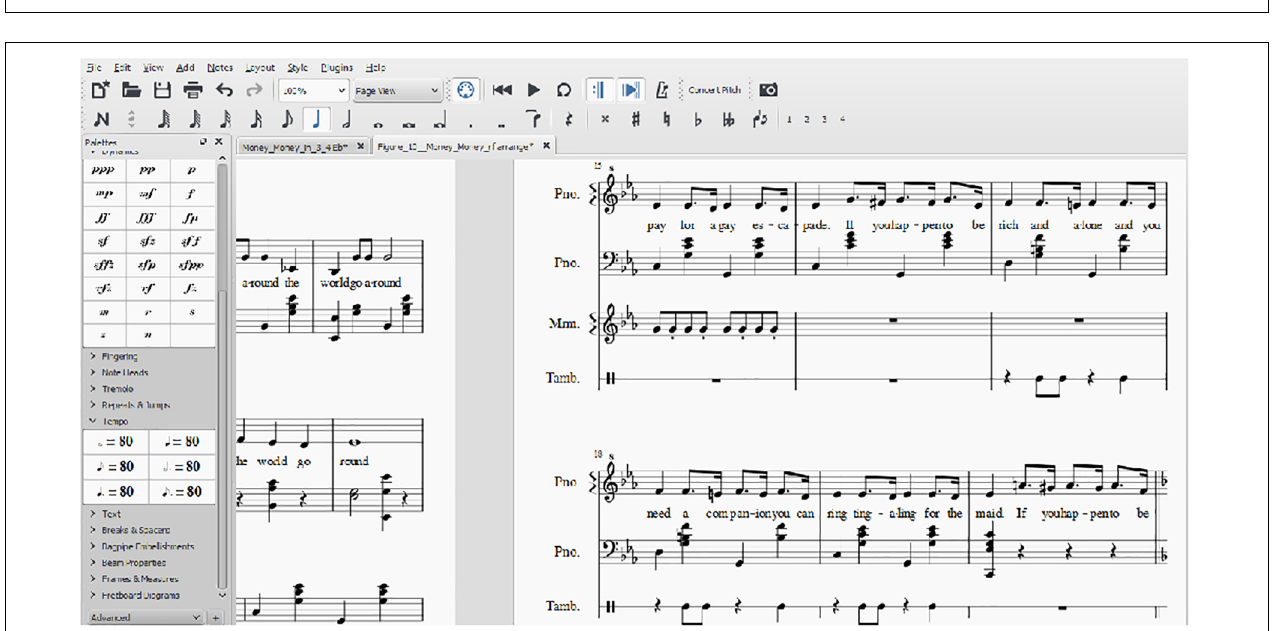
FIGURE 11 | Adding dynamics and tempo from the Palettes (left), and creating lines with ostinato.